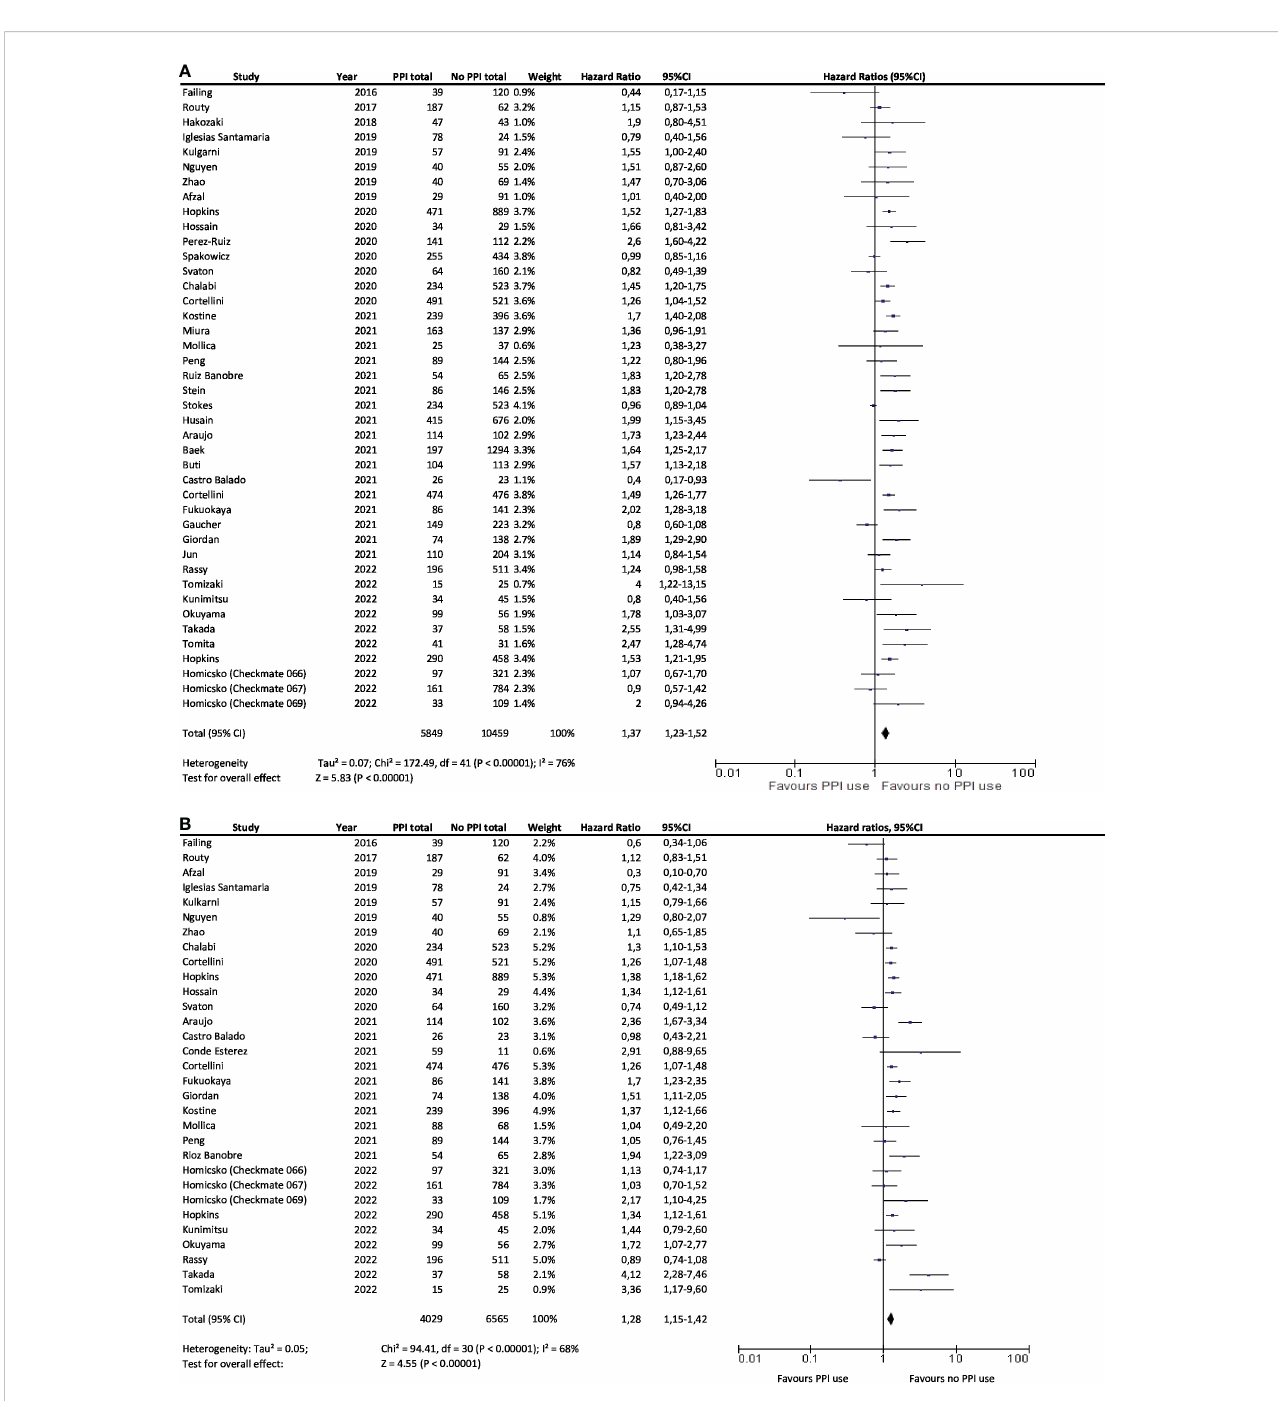
FIGURE 2 Association between PPI use and overall survival (A) and progression-free survival (B) in cancer patients treated with immunotherapy. PPI, proton pump inhibitor; CI, con fi dence